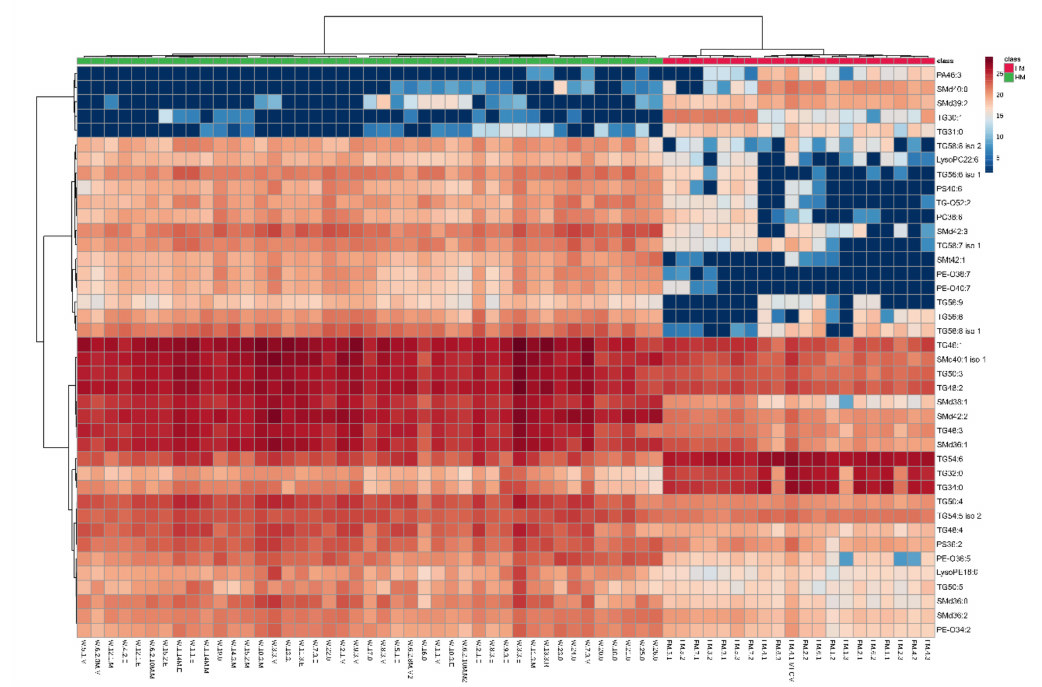
Figure 5. Clustering shown as a heatmap (distance measured using the Euclidean algorithm, and the clustering algorithm using Ward’s method). Top 40 lipid species di ff erentiating HM and FM samples according to Mann–Whitney test